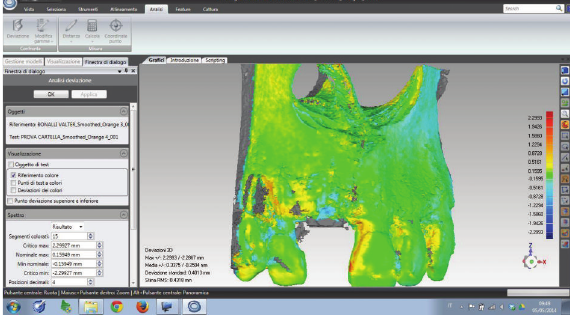
Figure 25: Overlapping of digital images. The DICOM (digital imaging and communication in medicine) files of the obtained CBCT datasets, 6 months and 2 years after grafting with synthetic, micromacroporous biphasic calcium-phosphate, were converted into a surface mesh model with digital imaging software (Mimics, Materialise, Leuven, Belgium). The two surface mesh models were then superimposed and rigidly aligned with anatomical landmarks, with the aid of a software for the overlapping of digital images (Geomagic Studio, Morrisville, NC, USA). The distance between the 2 surface meshes was presented as color-coded graded figures (blue: tissue loss; orange/red: tissue apposition; green/yellow: little or no modifications) to identify zones of bone resorption. In the frontal view, little or no buccal bone loss was evidenced, confirming the stability of the regenerated bone along time.